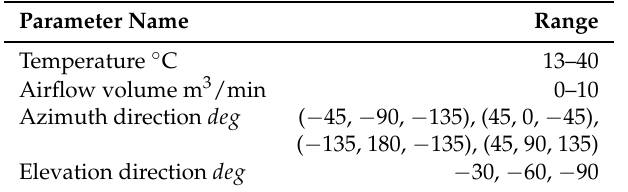
Table 1. Control parameters for the air conditioner in simulation.